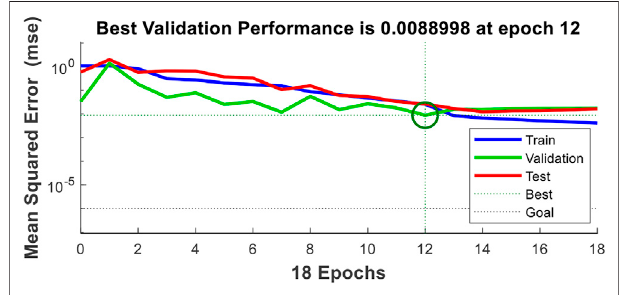
FIGURE 3 | Result of the BP